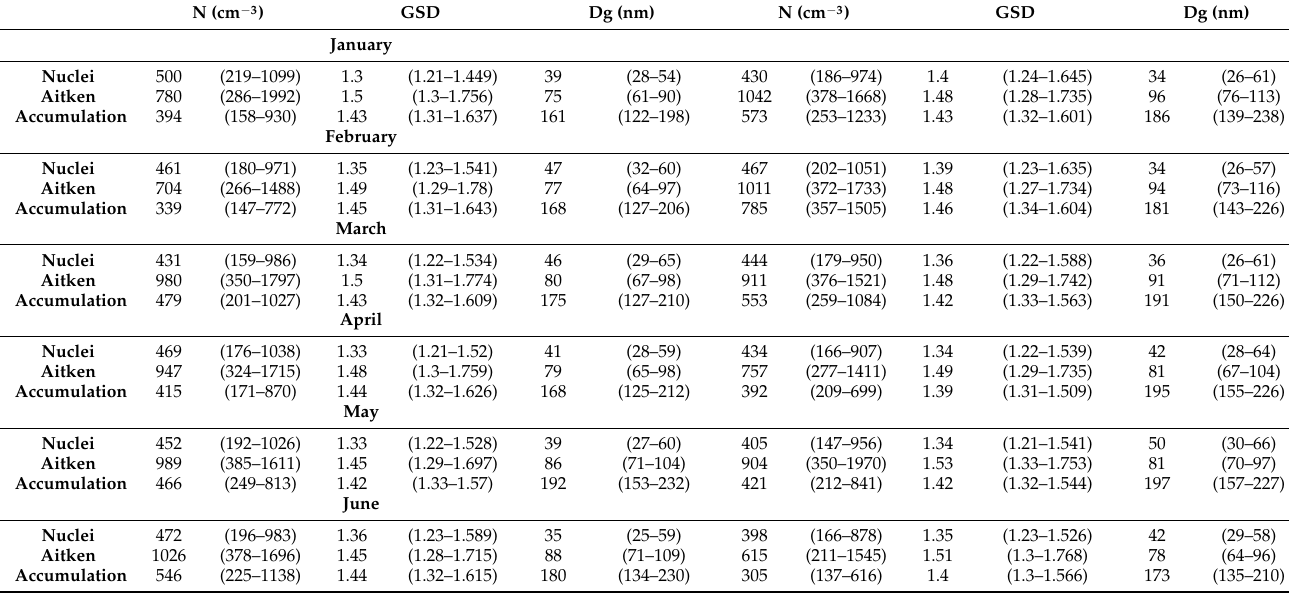
Table A1. Fitted modal parameters for NAVARINO, 2011–16 November 2013. (GSD stands for Geometric Standard Deviation and Dg for particle diameter as measured by a Differential Mobility Analyzer).